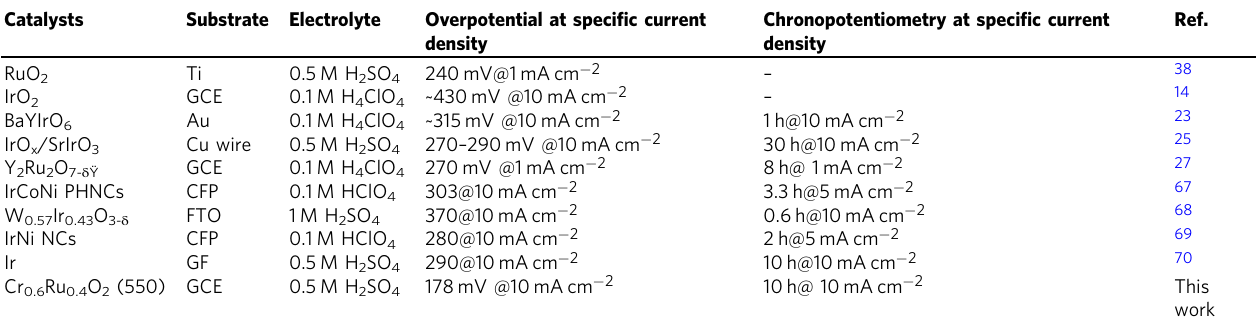
Table 1 Selected catalysts with high OER performance Catalysts Substrate Electrolyte